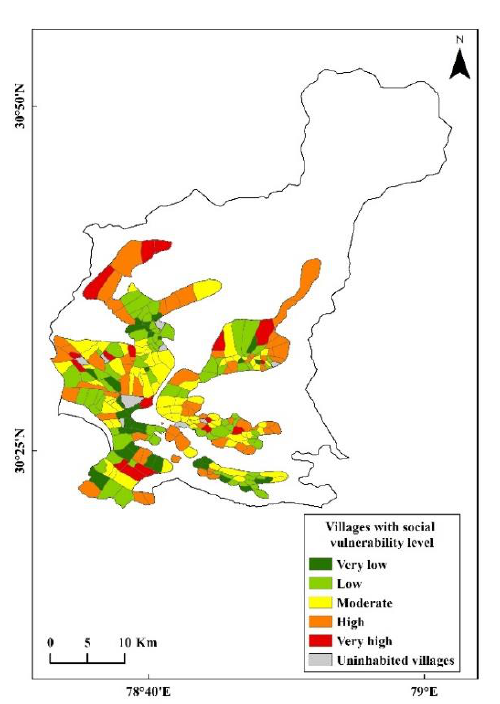
Figure 2. Distribution of social vulnerability index for the block All these villages exhibit very high economic vulnerability (Figure 1) and very low coping capacity (Figure 3), along with high physical and high to moderate social vulnerability (Figure